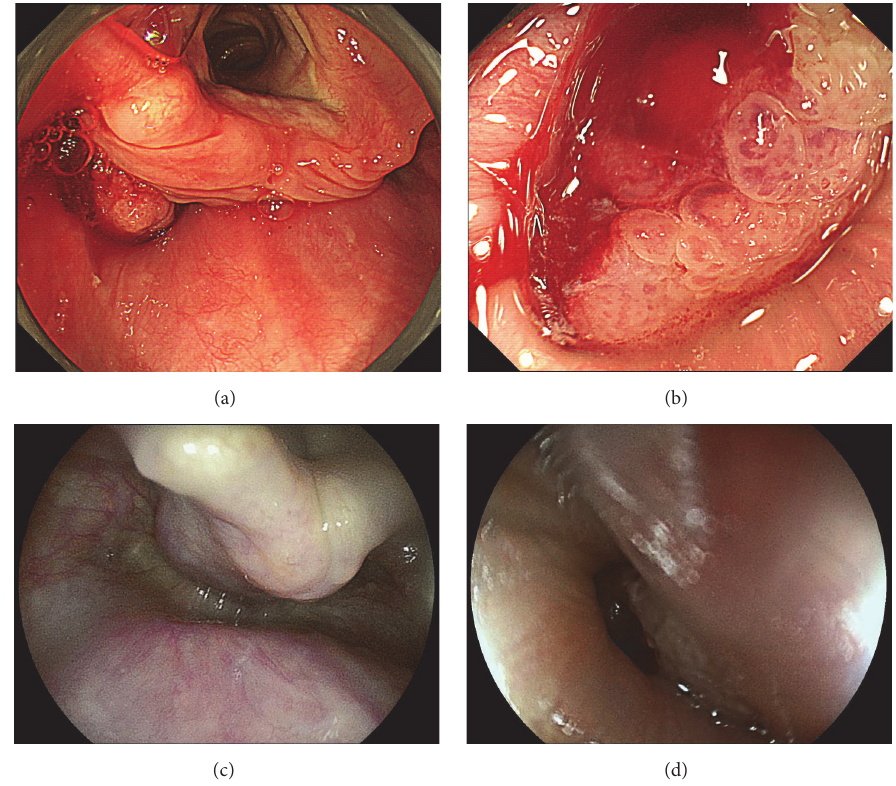
Figure 1: (a) Conventional endoscopy showed that the protruded mass was located at the left piriform sinus. (b) The tumor was very movable andwasdiagnosedascervicalesophagealcancer.(c)Transnasalendoscopyusingthetrumpetmaneuvershowedthatthetumorhadnotwidely invaded the hypopharynx. (d) The pedicle of the tumor was located at the left-anterior wall of the pharyngoesophageal